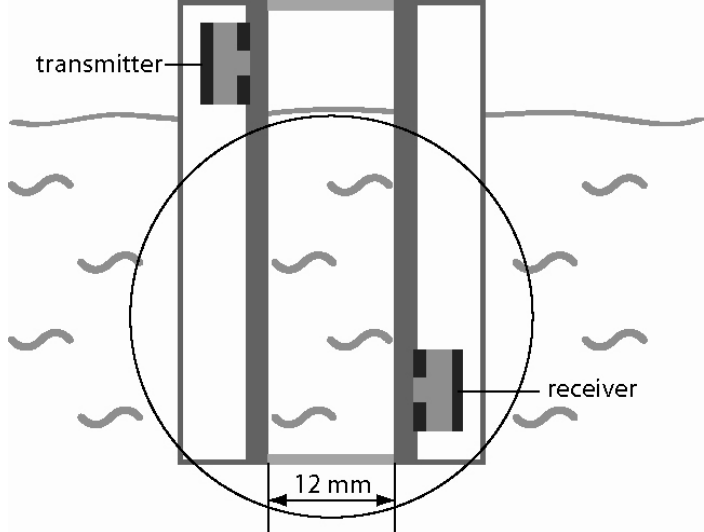
Figure 5. The measurement setup consists of two parallel glass plates at a distance of 12